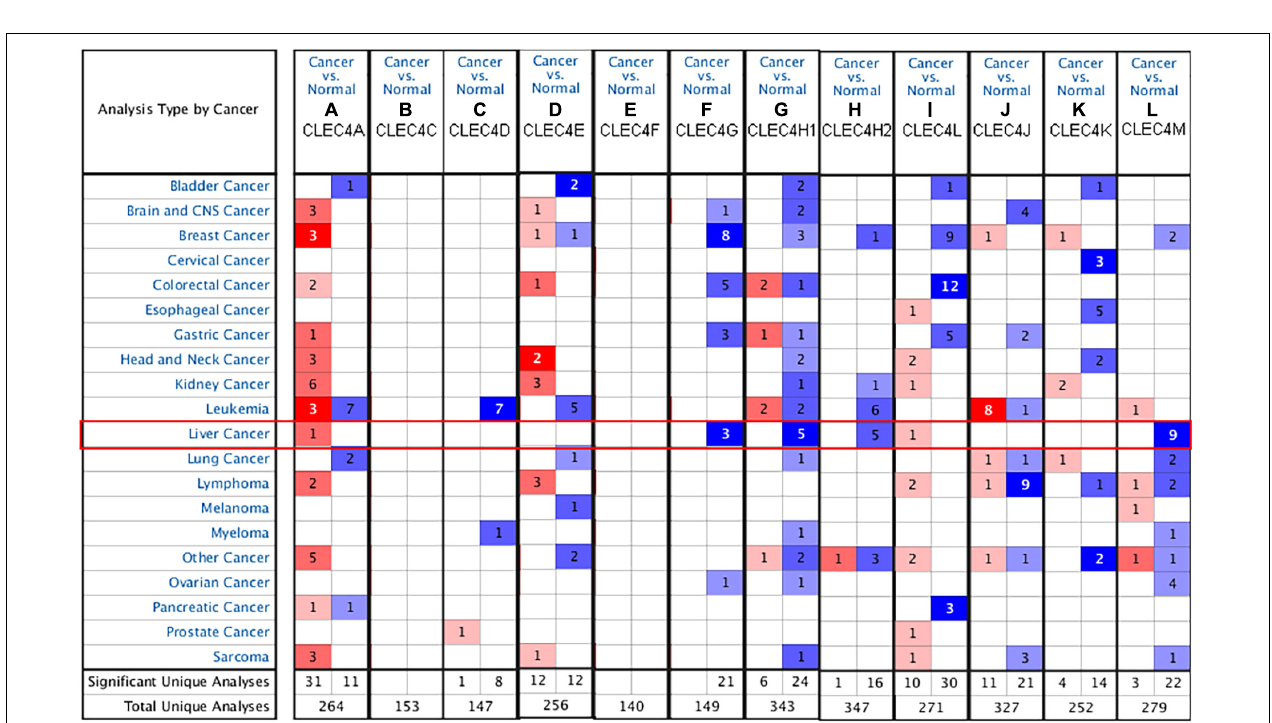
FIGURE 2 | mRNA levels of CLEC4s in liver hepatocellular carcinoma (LIHC) (ONCOMINE). (A) CLEC4A; (B) CLEC4C; (C) CLEC4D; (D) CLEC4E; (E) CLEC4F; (F) CLEC4G; (G) CLEC4H1; (H) CLEC4H2; (I) CLEC4J; (J) CLEC4K; (K) CLEC4L; (L) CLEC4M. The figure shows the numbers of datasets with statistically significant mRNA overexpression (red) or downregulated expression (blue) of genes in LIHC.